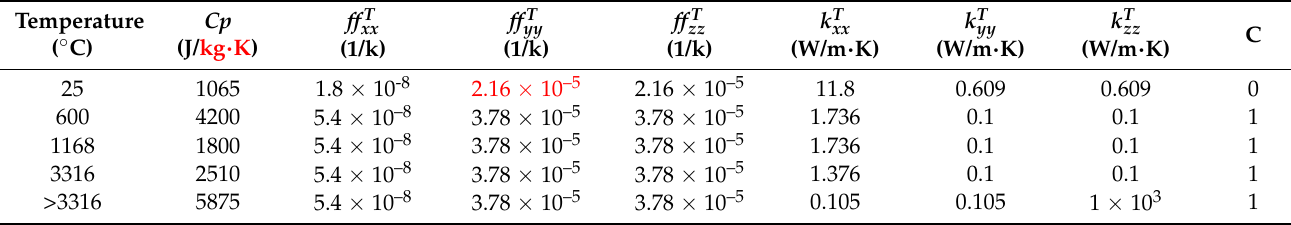
Table 1. Thermal parameters of the composites [20,21].